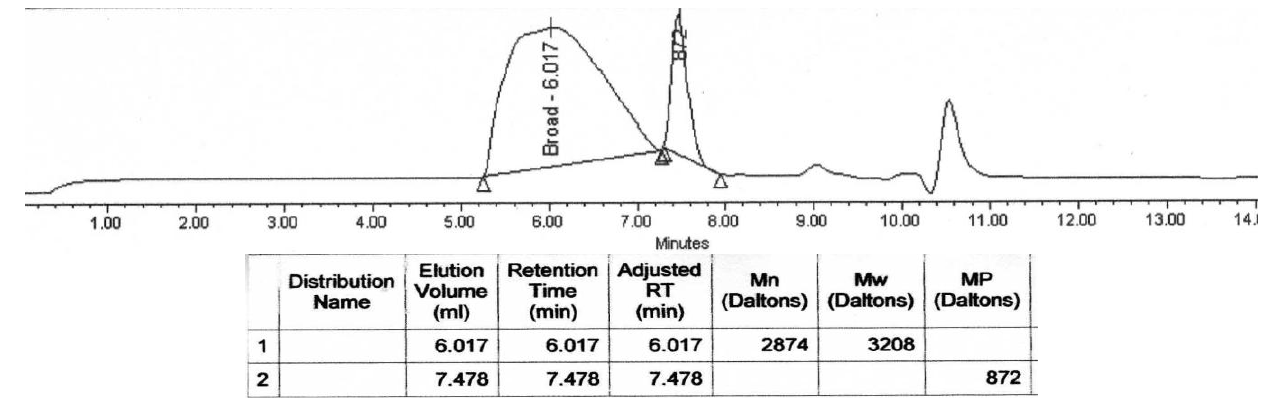
Figure 9. GPC chromatogram of buffer extracted oligomers of PolyHOPhe-CA after a week of